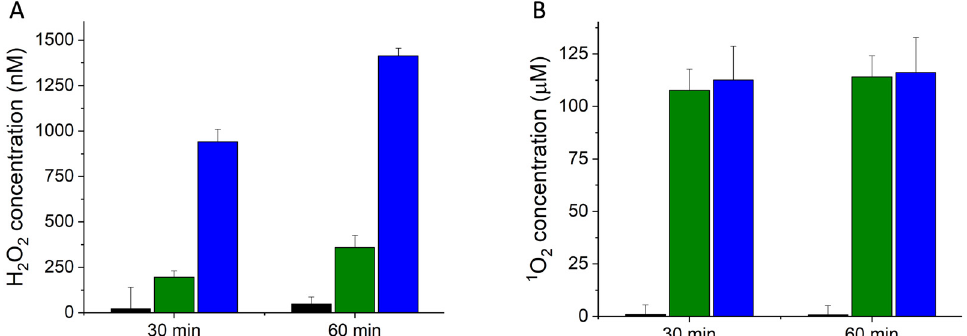
Figure 7. Quantification of ROS generated through type I ( A ) and type II ( B ) mechanisms at different irradiation times (30 min and 60 min), white light irradiation by Ce6 (green bars), Ce6@HSA (blue bars), and PBS (control, black bars). ( A ) Amplex Red assay for peroxides detection; ( B ) ABMDMA assay for 1 O 2 detection.